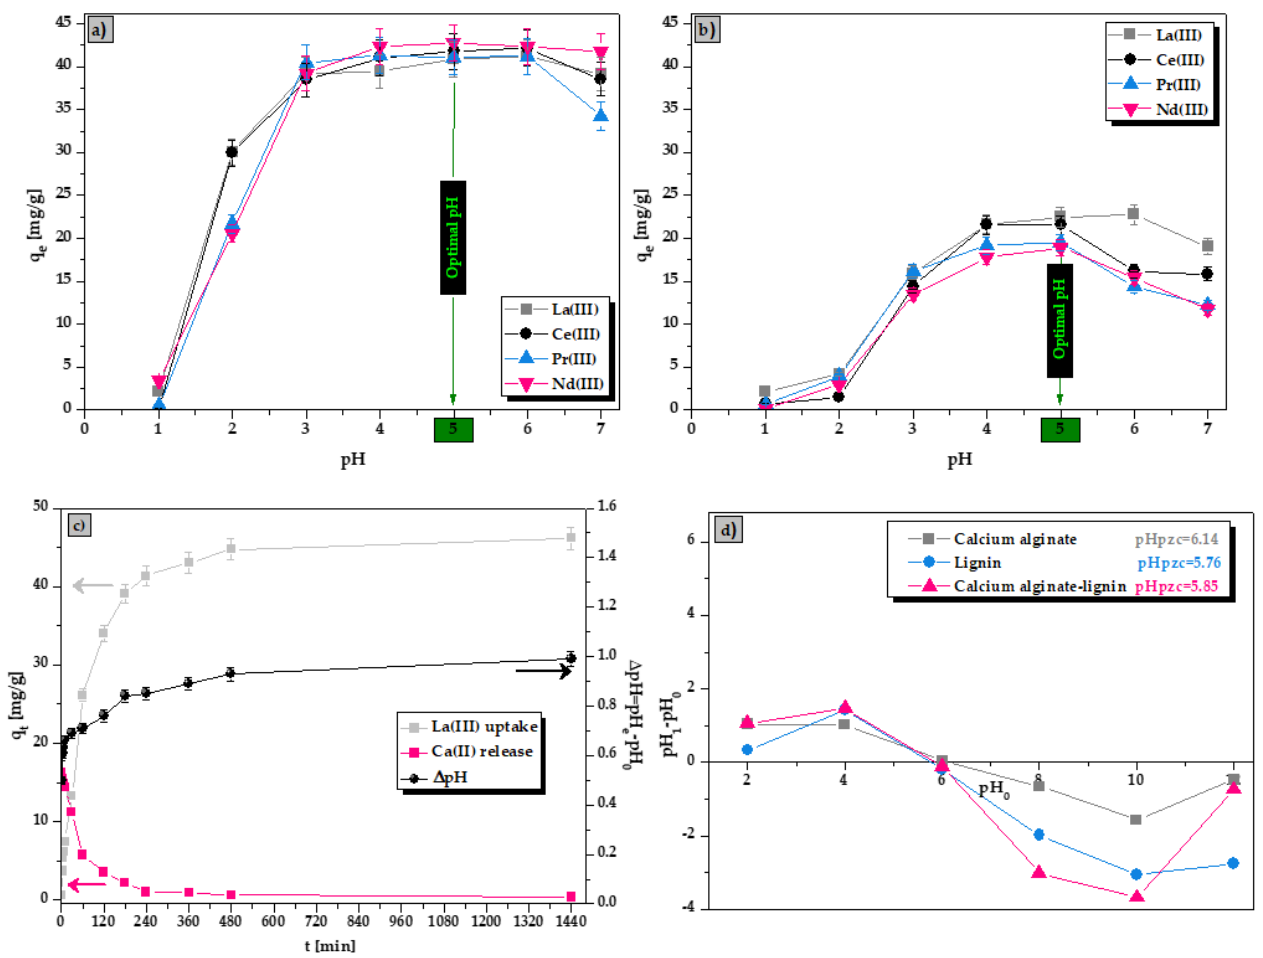
Figure 4. Influence of solution pH on the adsorption capacities of ( a ) ALG 5 L 1 composite and ( b ) lignin, ( c ) La(III) uptake, Ca(II) release and pH changes during contact time, and ( d ) comparison of pH pzc values of biosorbents (conditions: pH = 1 – 7, C 0 = 100 mg/dm 3 , m = 0.05 g, V = 20 cm 3 , t = 480 min, T = 293 K).